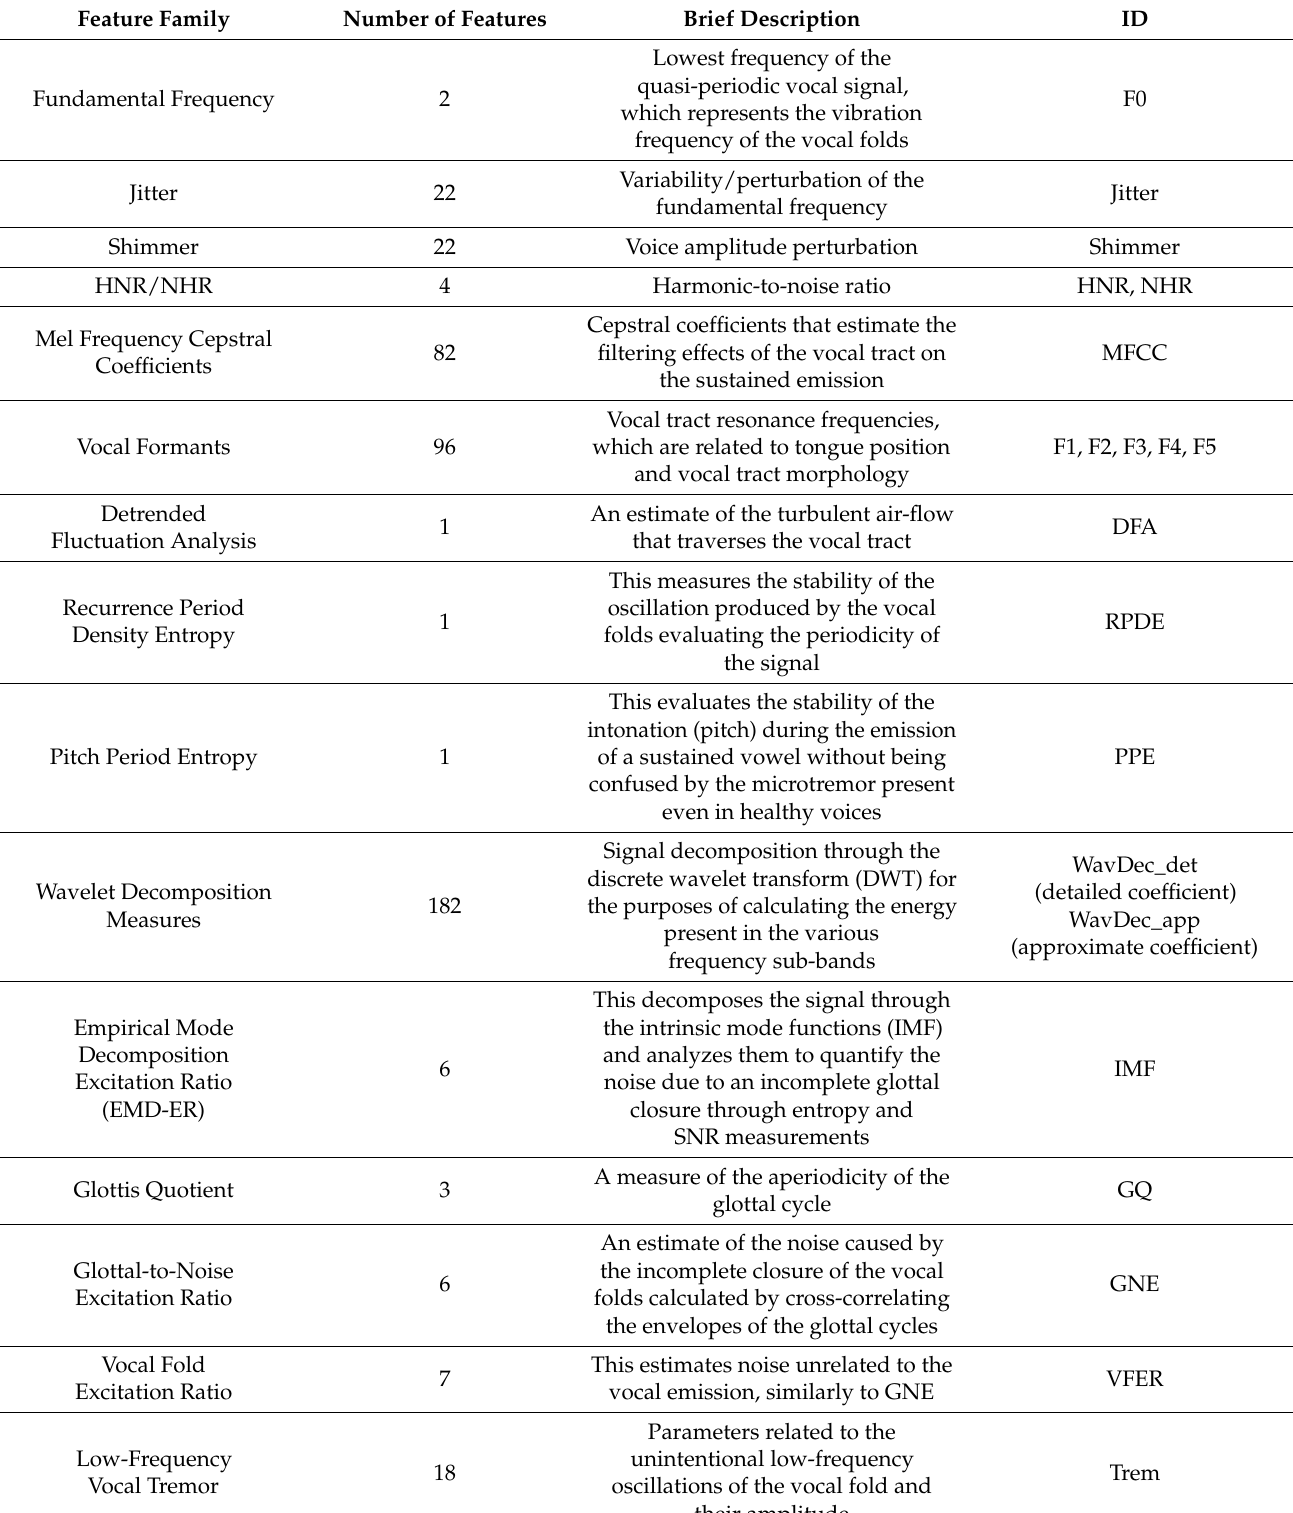
Table 2. Summary of the 453 extracted